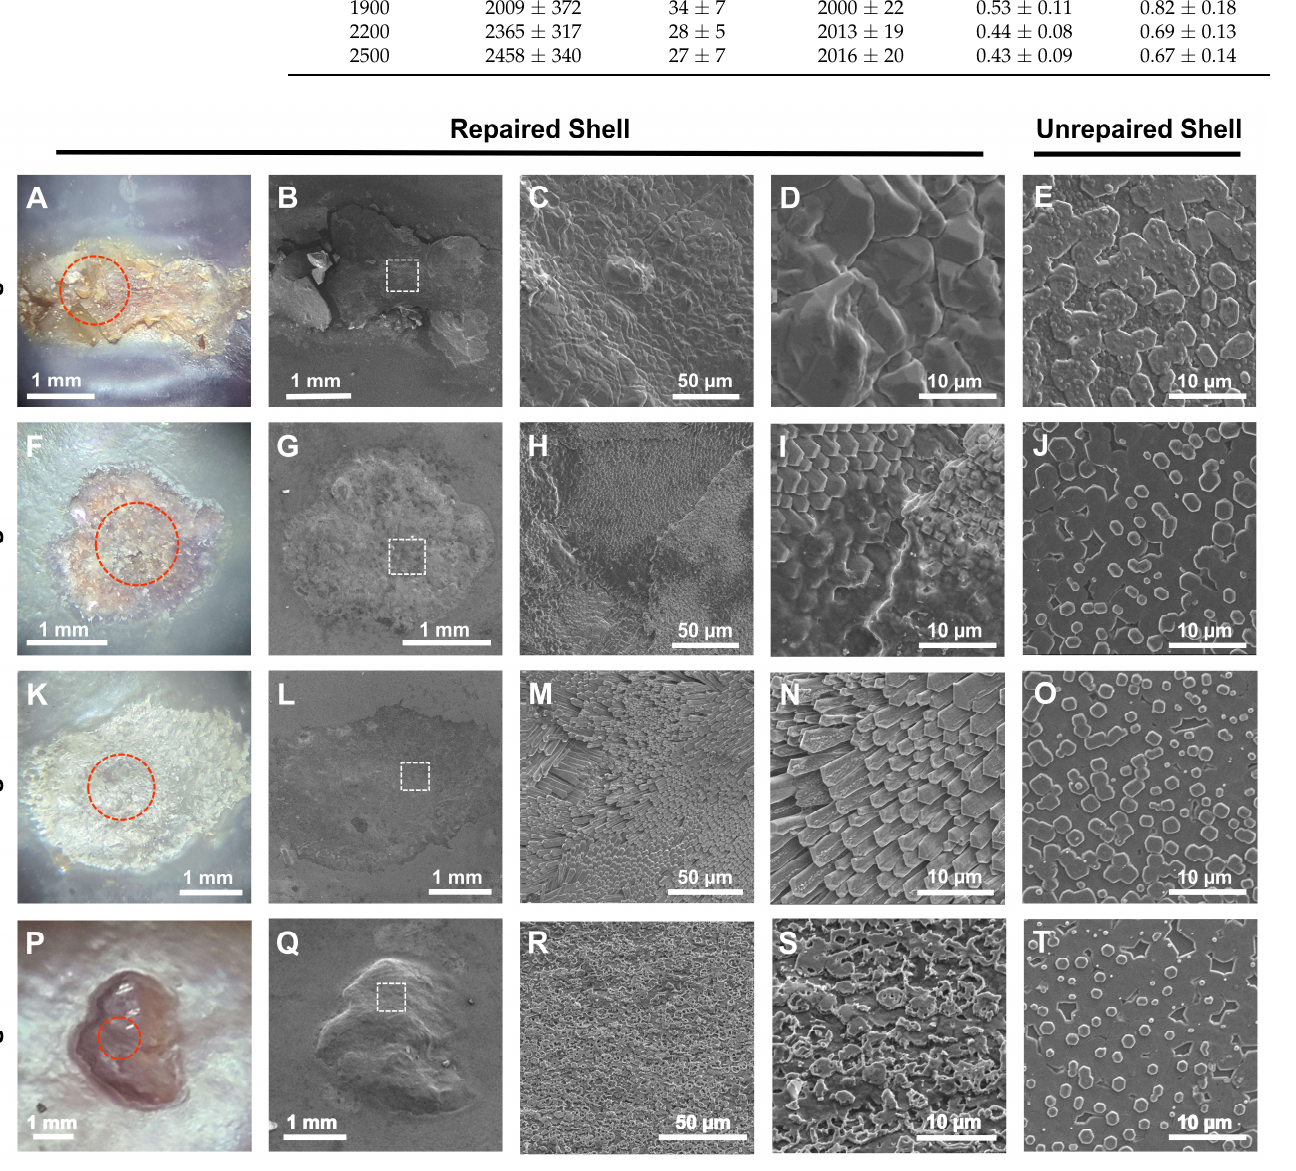
Figure 4. Light and SEM images of repaired drill holes at Stage 1 (S1; ( A – E )), Stage 2 (S2; ( F – J )), Stage 3 (S3; ( K – O )), and Stage 4 (S4; ( P – T )), from the valve interior of mussels ( M. trossulus ) exposed to 400 µatm p CO 2 for 15, 28, 43, and 69 days, respectively. Red circles represent the location of drill holes within light microscopy images; white boxes are the scan area used for magnified SEM images. Images for each repair stage were each taken from the same mussel; image magnification for SEM images increases from left to right within each row (25×, 1000×, 3000×). The last panel within each row is an image of unrepaired shell away from the repair within the same individual (3000×).